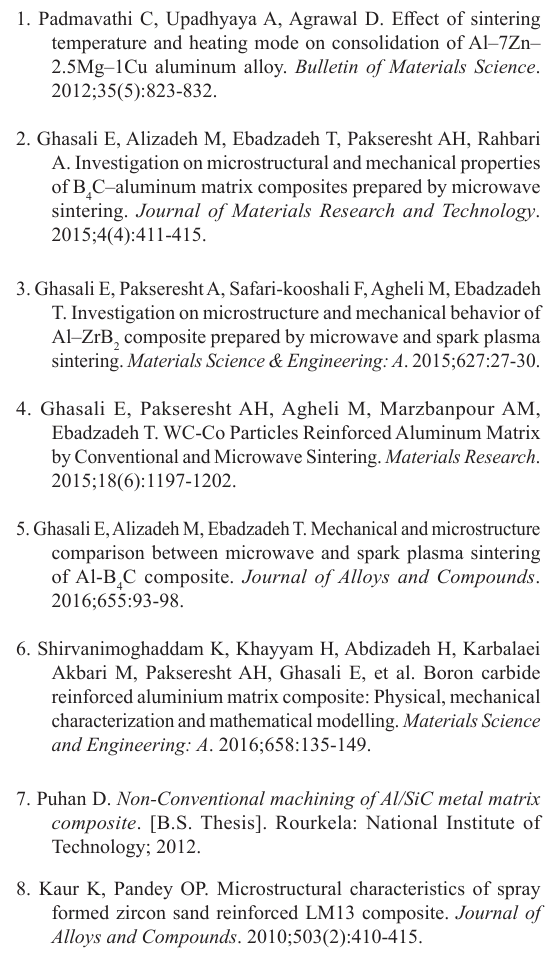
Table 4: Mechanical strength of aluminum based composites. Temperature (°C) 650